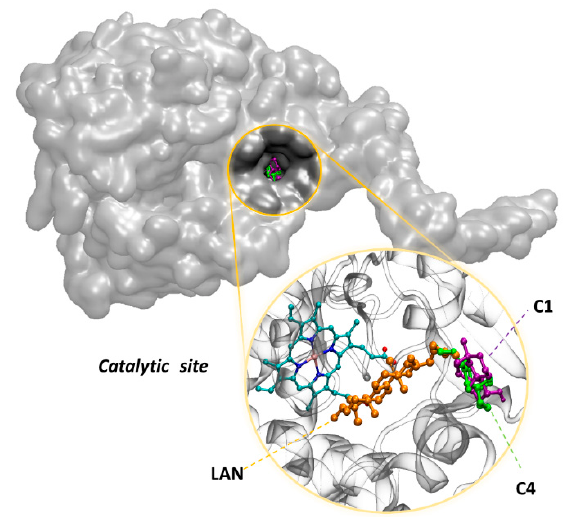
Figure 1. (a) Best ranked binding poses for the association of C1 (purple) and C4 (green) to 14-alpha demethylase obtained from protein-ligand docking calculations with the CB-dock server. (b) Structural superposition between the 14-alpha demethylase complexes with C1 (purple), C4 (green) and LAN (orange) obtained protein–ligand docking calculations.